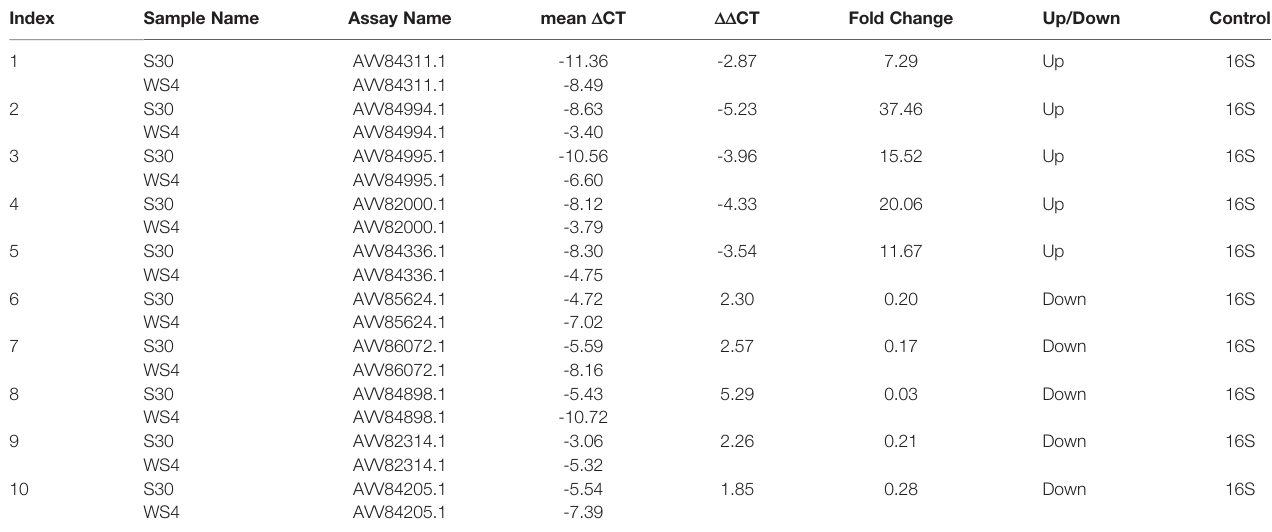
TABLE 3 | The results of the qRT-PCR